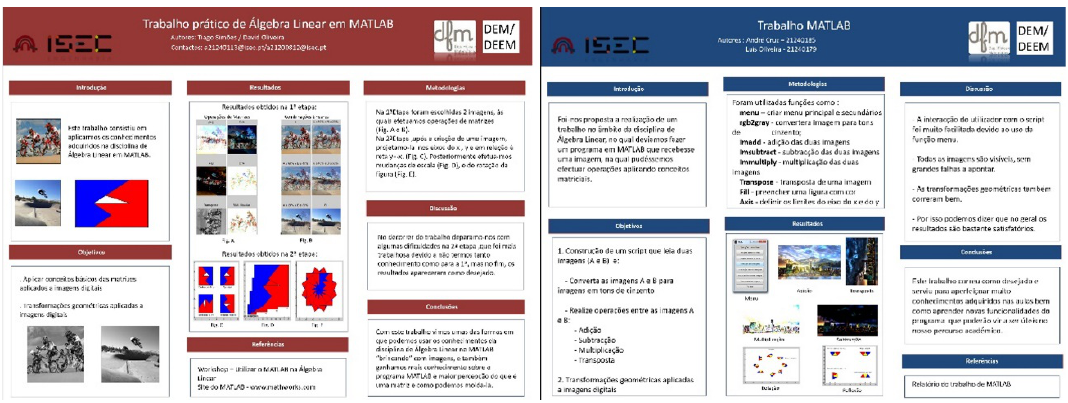
Figure 8. Posters developed by the